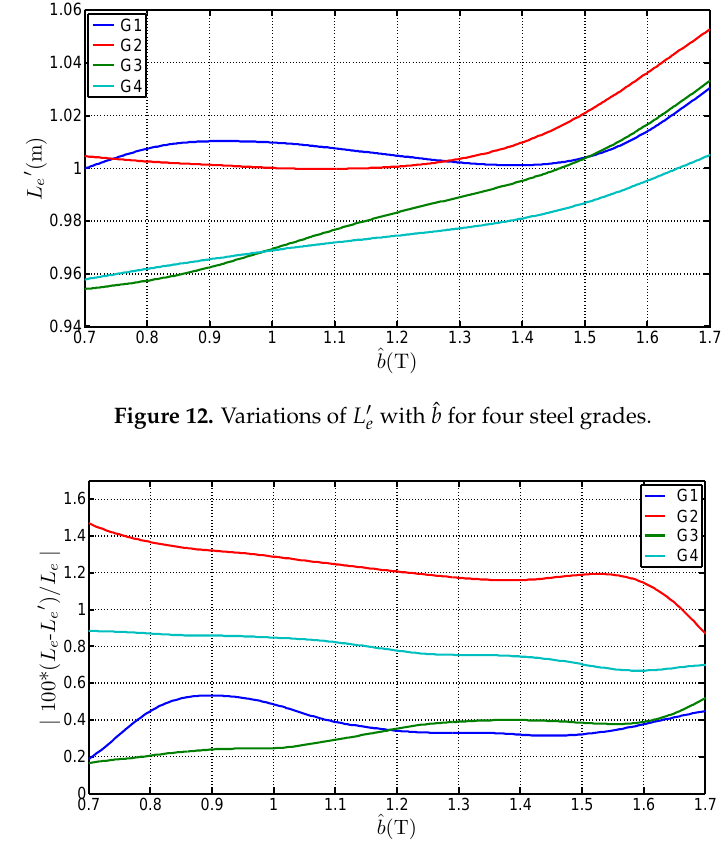
Figure 13. Comparison of L (cid:48) e and L e with ˆ b for four steel